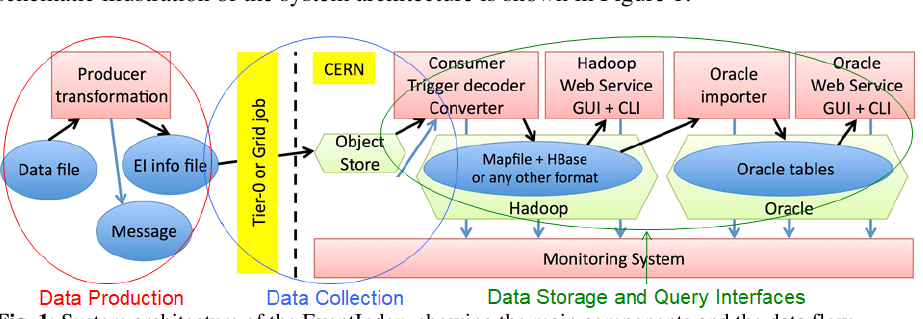
Fig. 1 : System architecture of the EventIndex, showing the main components and the data